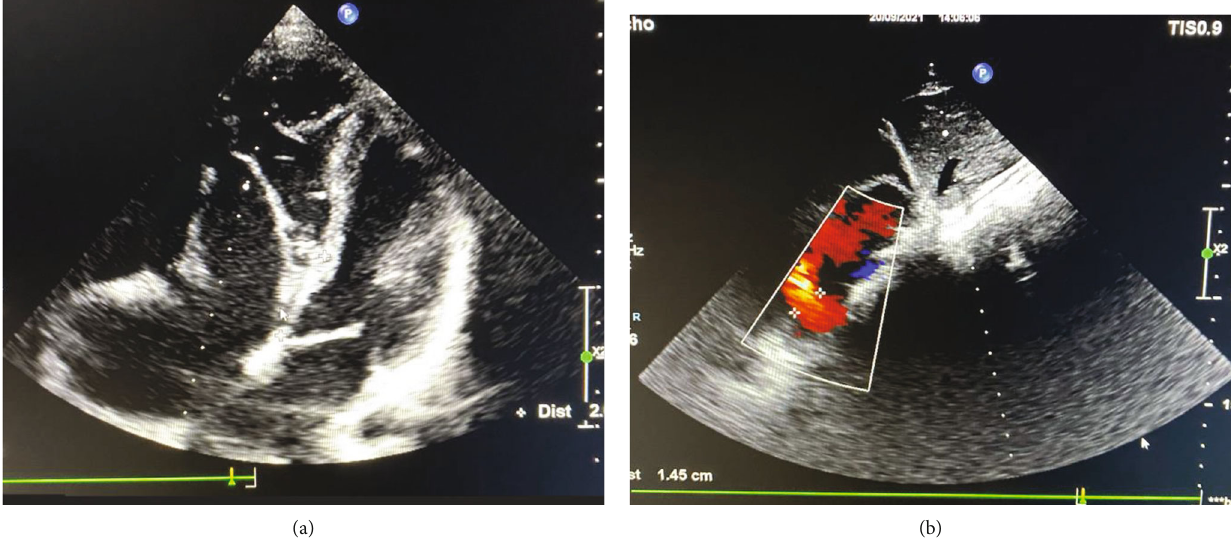
Figure 2: (a) Echocardiogram shows situs solitus, levocardia, left side aortic, and Ebstein types B-C. (b) ASD size of 8.3mm with left to right